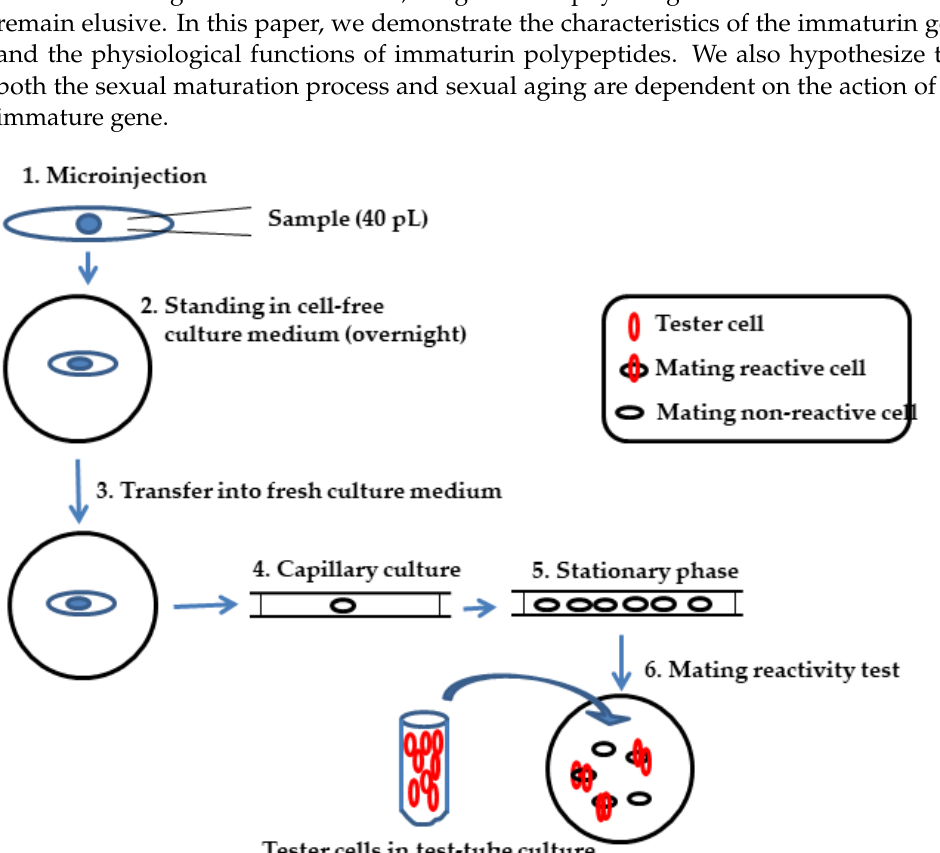
Figure 1. Schematic of immaturin bioassay with microinjection and capillary culture. Since the odd-mating-type cells were used as the recipients of microinjection, the even-mating-type cells were used as the tester to evaluate the mating activity. The strength of the mating activity of each clone derived from microinjection is expressed as the percentage of cells mated with the tester to the total number of cells used in the test. The effect of injection of immaturin was determined to be when less than 70% of the cells constituting the clone had a mating